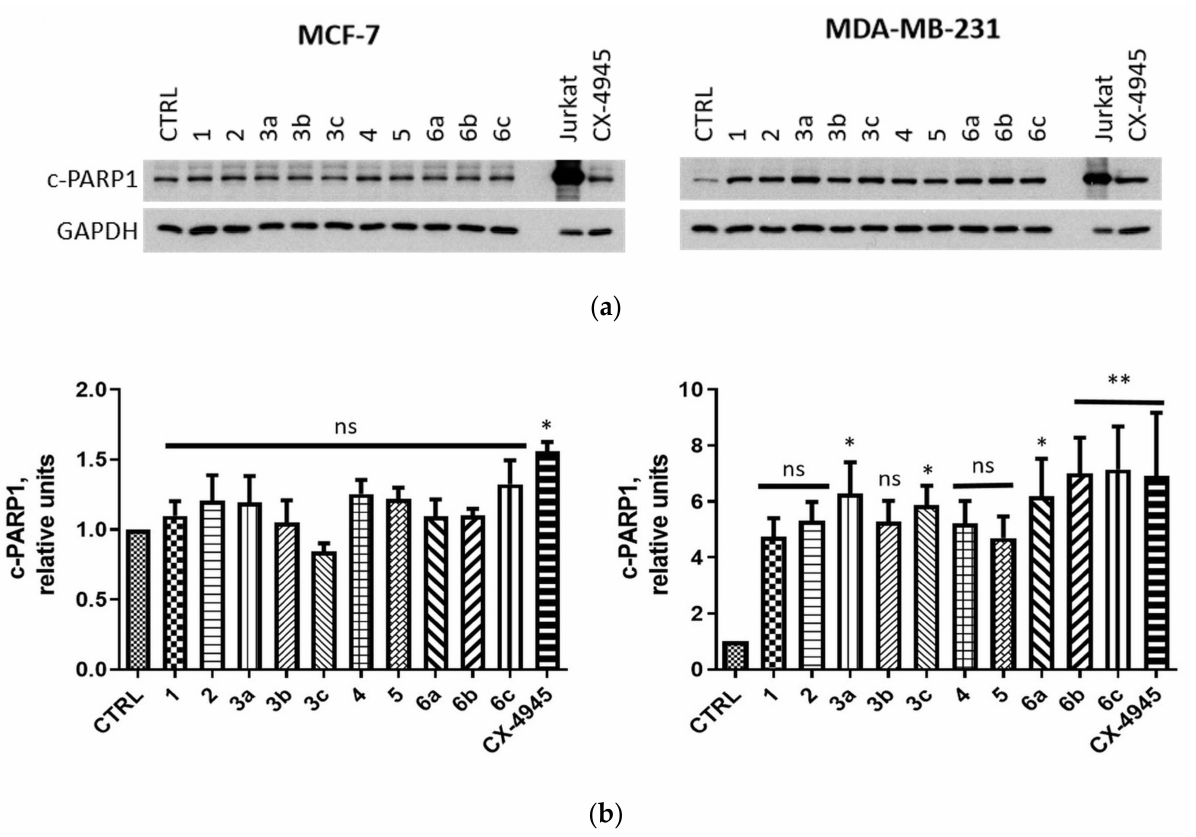
Figure 7. Effect of compounds 1 , 2 , 3a – c , 4 , 5 and 6a – c on the level of cleaved PARP1 (c-PARP1) in MCF-7 and MDA- MB-231 cells. Cells were treated with compounds 1 , 2 , 3a – c , 4 , 5 and 6a – c used in the concentrations corresponding to their EC 50 values for 24 h and subsequently the respective crude extracts were subjected to Western blot analysis (see “Western Blotting”) with the specific antibodies against c-PARP. GAPDH was used as a protein loading control for each sample. ( a ) The representative blots. UV-irradiated Jurkat cells were used as a positive control (see “Western Blotting”). ( b ) Densitometry analysis for c-PARP1. Untreated cells served as the reference point (one relative unit). Graphs represent mean values ± s.e.m. * p < 0.05, ** p < 0.01 relative to control; ns—not